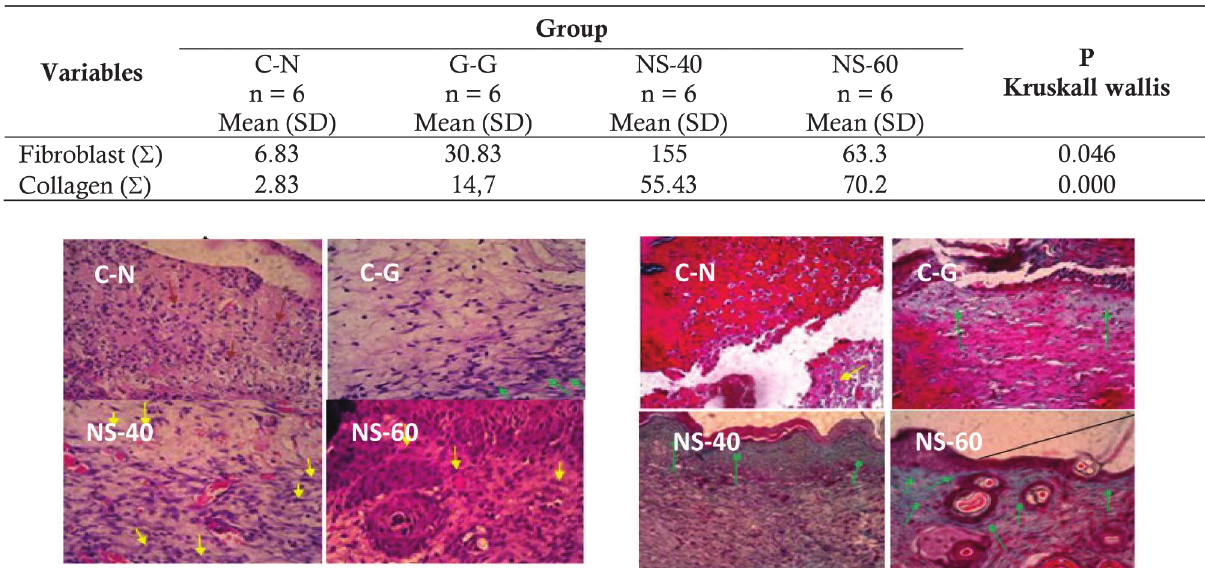
Nigella Sativa Seed Extract Ointment Increasing the Amount of Healing Fibroblast and Collagen on Balb/C Mice ... Table 1. The number of Fibroblasts with HE staining (Hematoksili eosin)